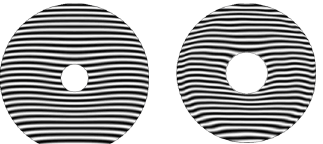
Fig.1. Model interferogram of the required wavefront (left) and the one actually obtained in the process of machining